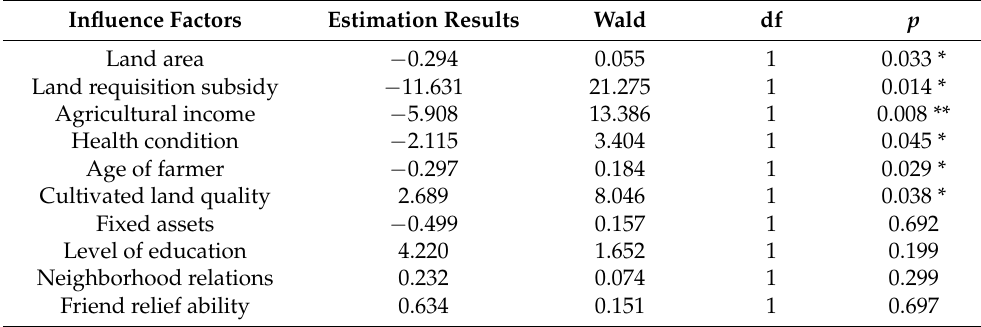
Table 2. Importance of factors affecting farmers’ attitude towards land requisition. (*: p < 0.05, indicating significant difference; **: p < 0.01, indicating extremely significant difference.)